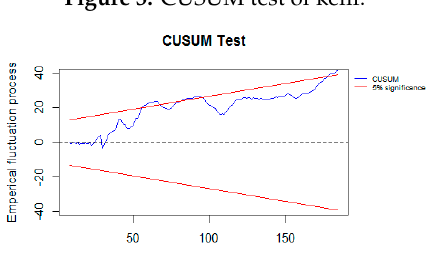
Figure 4. CUSUM test of butter cream.